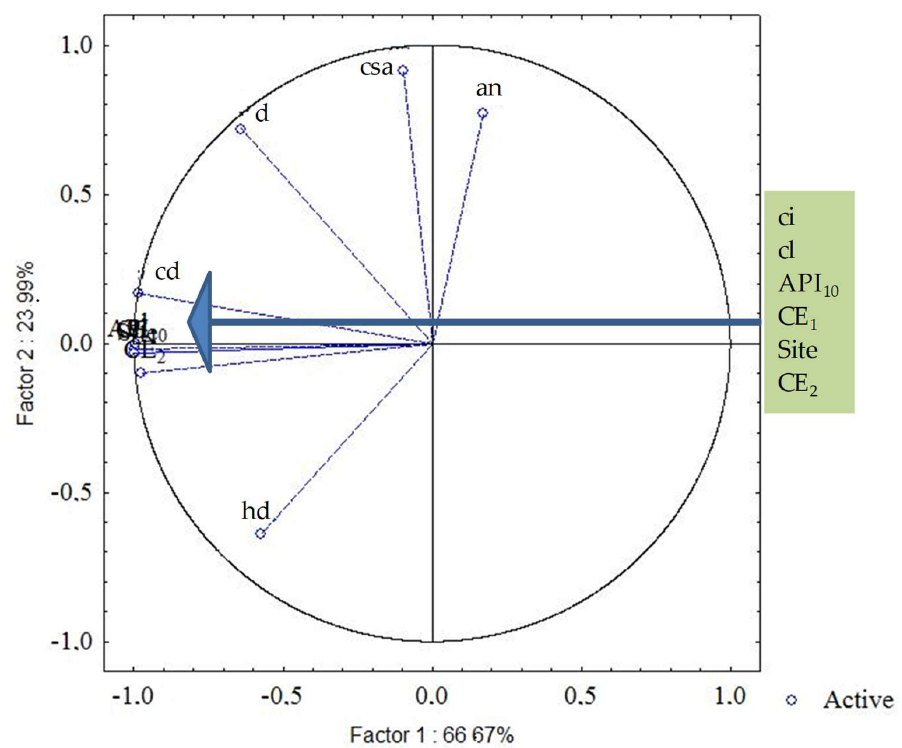
Figure 5. Circle of correlations between number of male strobili and dendrometric and morphometric variables for A. angustifolia . The blue arrow and the green frame on the right indicate the original variables grouped in the principal components circle, which: cl = crown length; hd = degree of slenderness; CE = crown efficiency; API 10 = annual periodic increment in diameter; ci= coverage index; csa = crown surface area; cd = crown diameter; d = diameter at breast height; an = male strobili number.